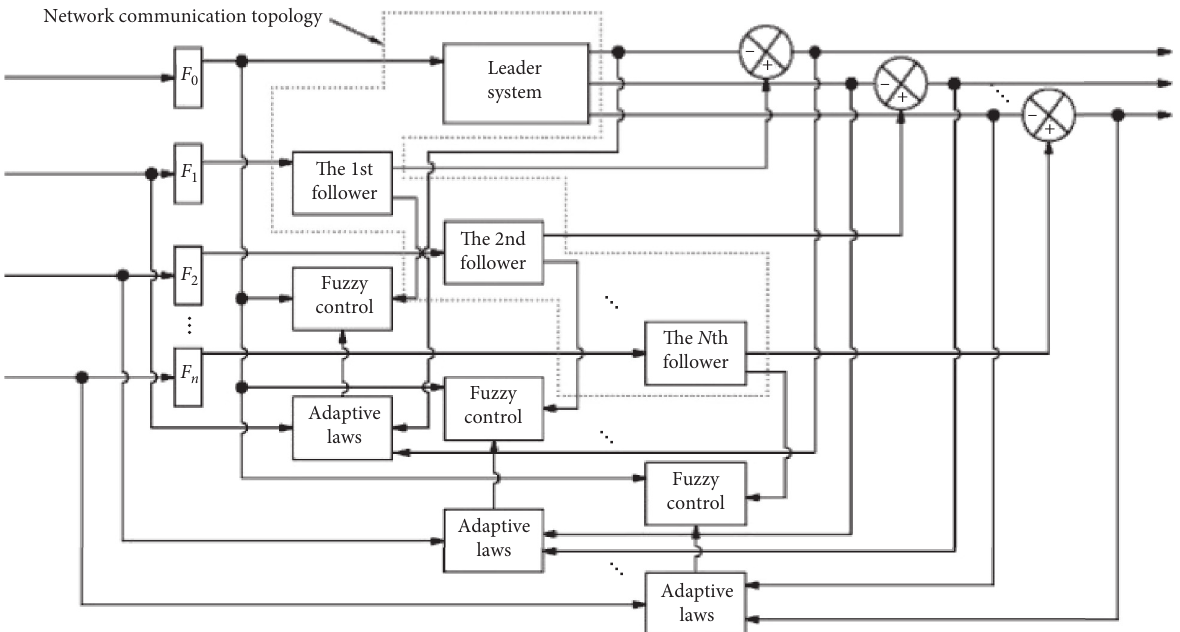
Figure 1: The block diagram of closed-loop multiagent systems.